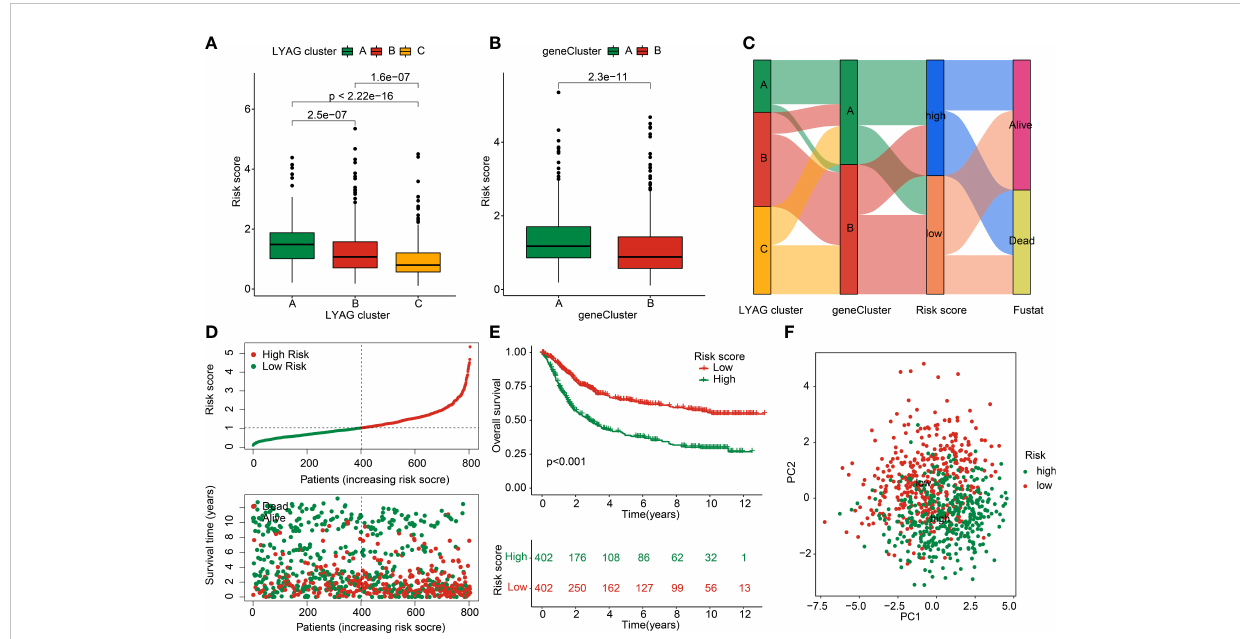
FIGURE 6 Construction of LYAG subtype-related DEGs risk model in GC. (A) Risk score in LYAG subtypes. (B) Difference analysis of risk score in gene cluster. (C) Relationship of risk score and LYAG cluster, gene cluster and clinical survival status. (D) Risk model construction for GC. (E) Clinical prognostic analysis of GC samples in low- and high-risk groups. (F) PCA